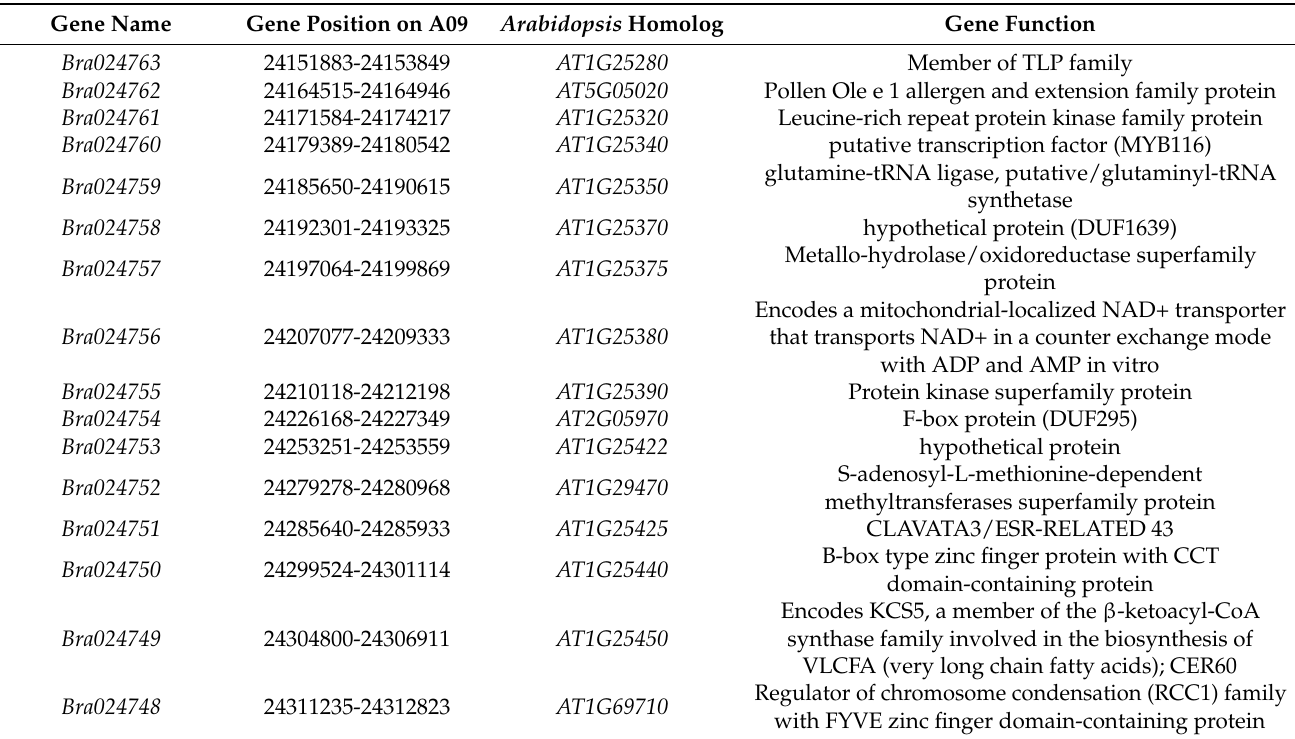
Table 2. Annotated genes in the candidate interval of the BrWAX3